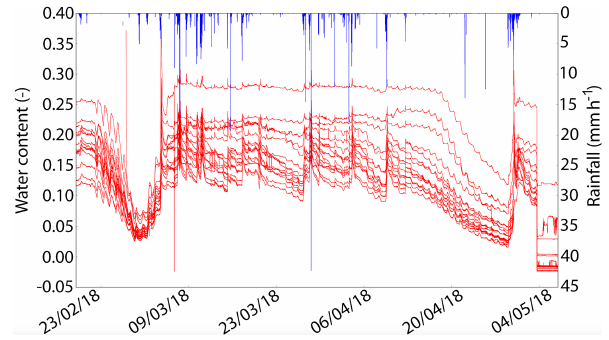
Figure 6. Rainfall and volumetric water content (m 3 m − 3 ) for 16 TDR